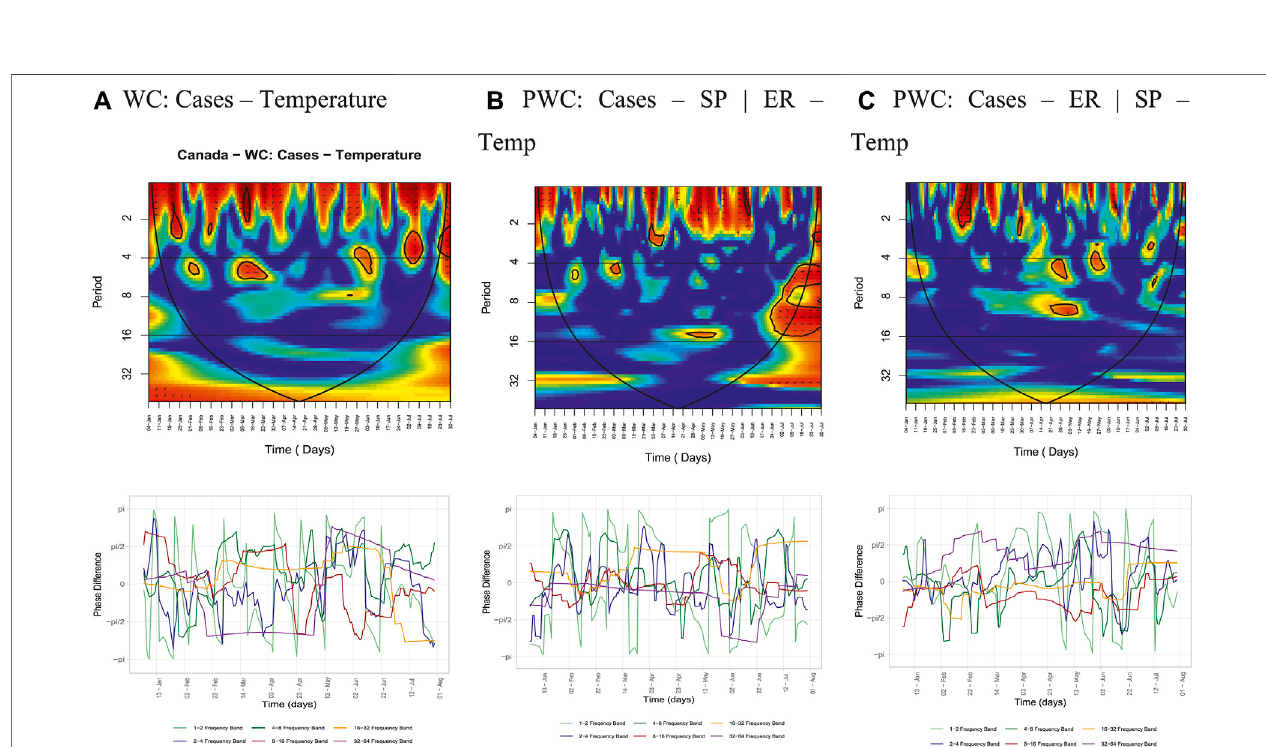
FIGURE 3 | Canada. (A) WC: Cases — Temperature. (B) PWC: Cases — SP | ER — Temp. (C) PWC: Cases — ER | SP — Temp.